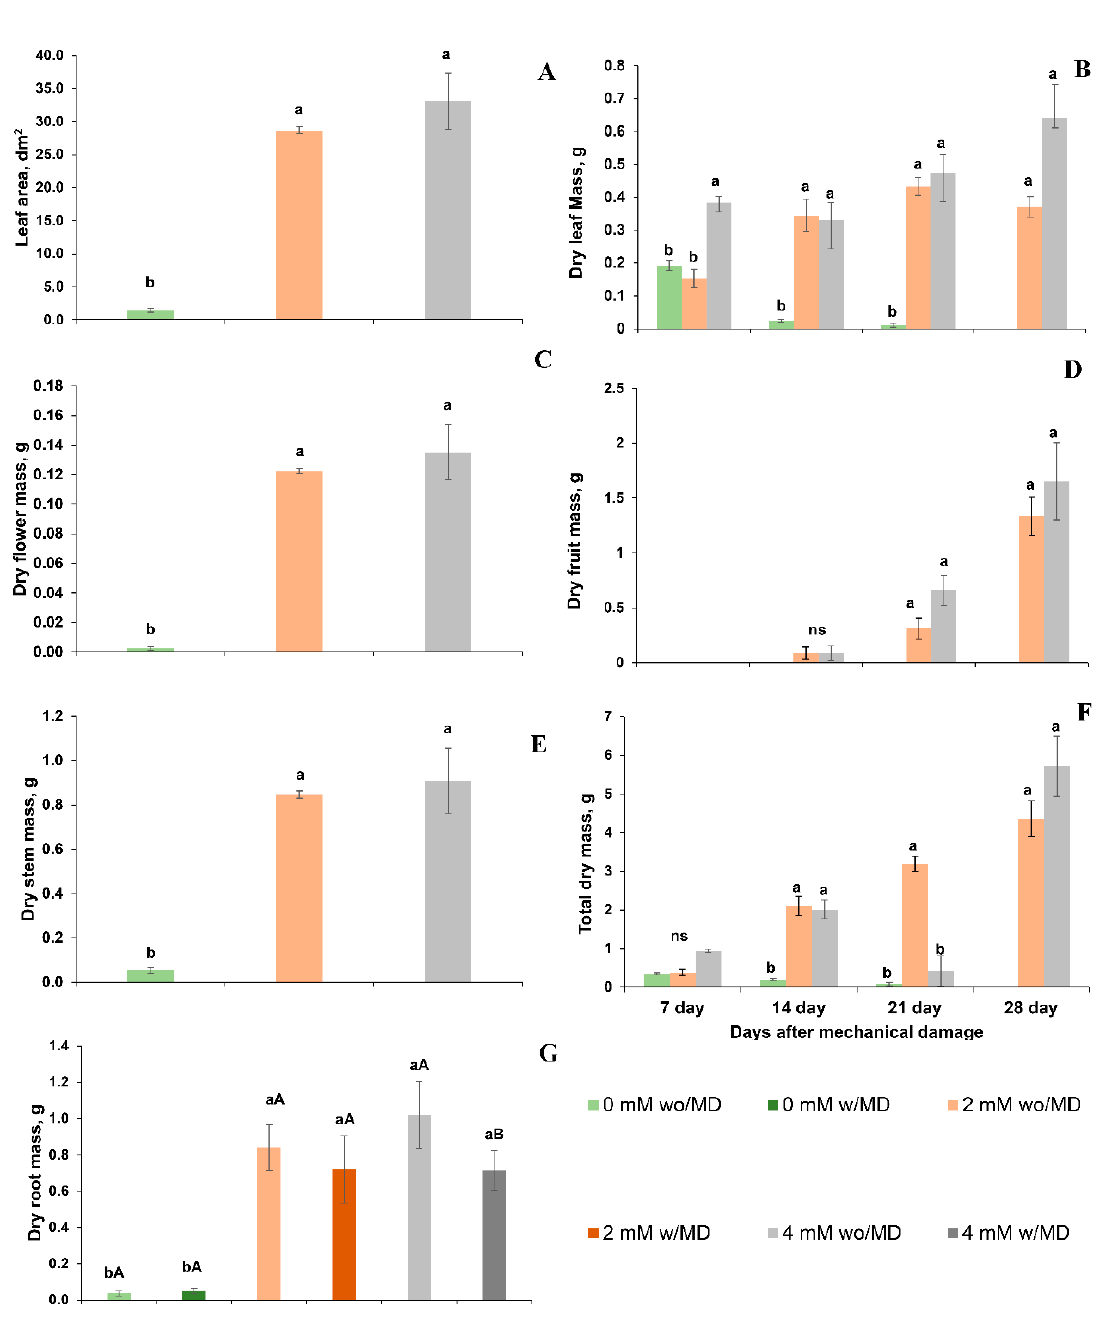
Figure 8. ( A ). Leaf area (dm 2 ) damage × calcium p < 0.011; ( B ). leaf dry mass (g) time × damage × calcium p < 0.004; ( C ). flower dry mass (g) damage × calcium p < 0.022; ( D ). fruit dry mass (g) time × calcium p < 0.037; ( E ). stem dry mass (g) damage × calcium p < 0.008; ( F ). root dry mass (g) damage × calcium p < 0.010; ( G ). total dry mass (g) time × damage × calcium p < 0.001, in Solanum lycopersicum “cv. Micro-Tom” grown with variation in calcium concentration (mM) and with (w/MD) or without (wo/MD) mechanical damage. Different lowercase letters indicate a significant difference in calcium levels within wo/MD or w/MD plants. Capital letters test wo/MD and w/MD plants within the same calcium level. ns = not significant at 5% Tukey test. Bars correspond to averages, whiskers to ± SE ( n =